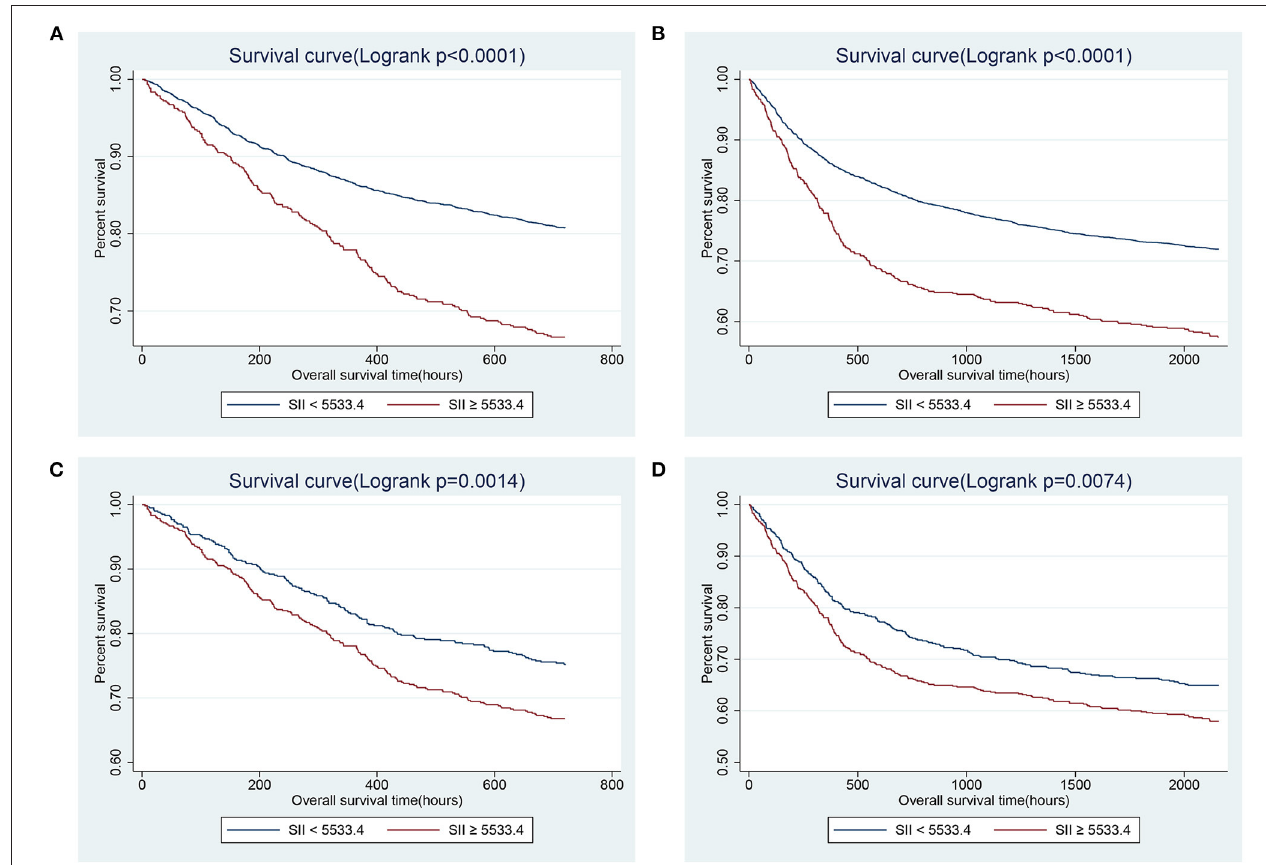
FIGURE 5 | Kaplan-Meier survival curves showing the 30- (A) and 90- (B) day all-cause mortalities stratified by cut-off value of SII in critically ill patients with CHF before PSM. (C,D) presented the correlation between SII and 30- and 90-day mortalities after PSM, separately. SII, systemic immune-inflammation index. CHF, congestive heart failure. PSM, propensity score